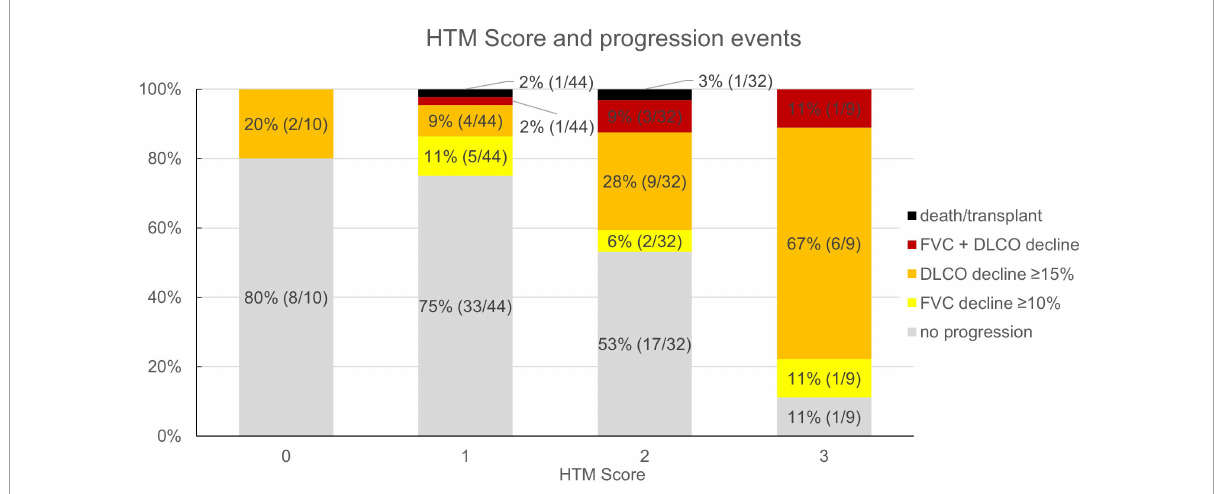
FIGURE4 Honeycombing, traction bronchiectasis, and monocyte score and fraction (number) of progression events in the derivation cohort ( n = 95). HTM, honeycombing, traction bronchiectasis, and monocyte; FVC, forced vital capacity; DLCO, diffusion capacity for carbon monoxide.